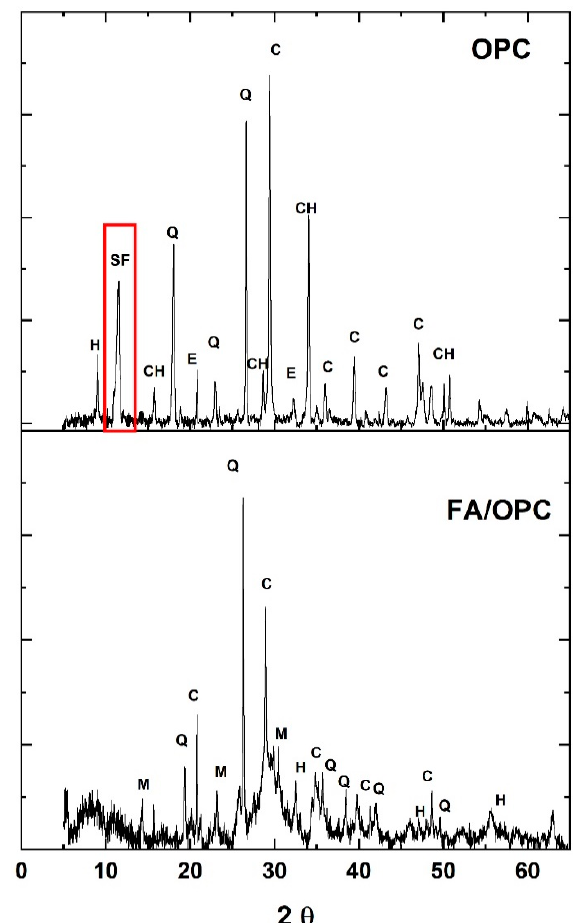
Figure 10. X-ray diffractogram of the FA/OPC and OPC pastes exposed to 3.5% NaCl for a period of 180 days.